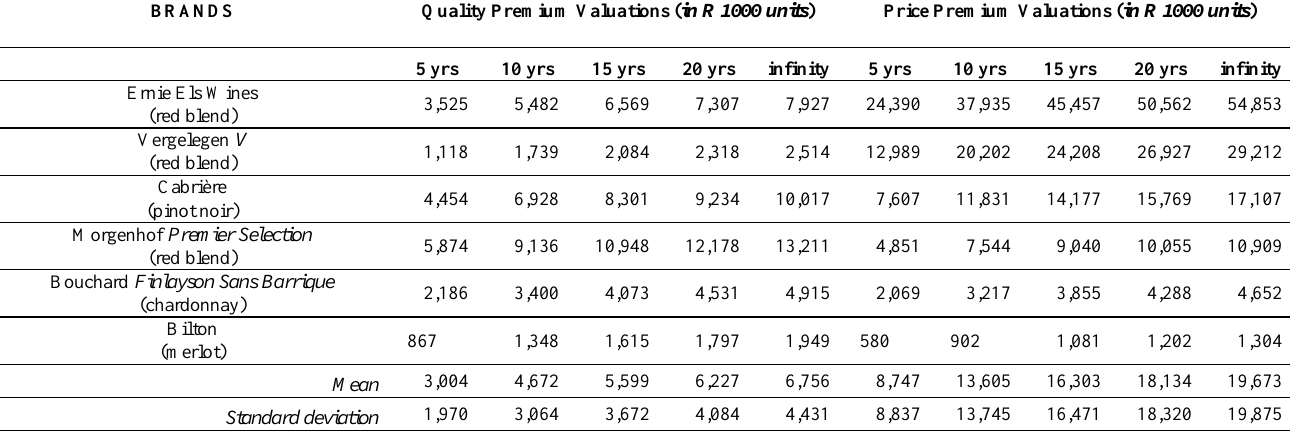
Table 7: How the time period for the NPV calculation affects the final brand valuations. (All Rand figures as of 2007.)